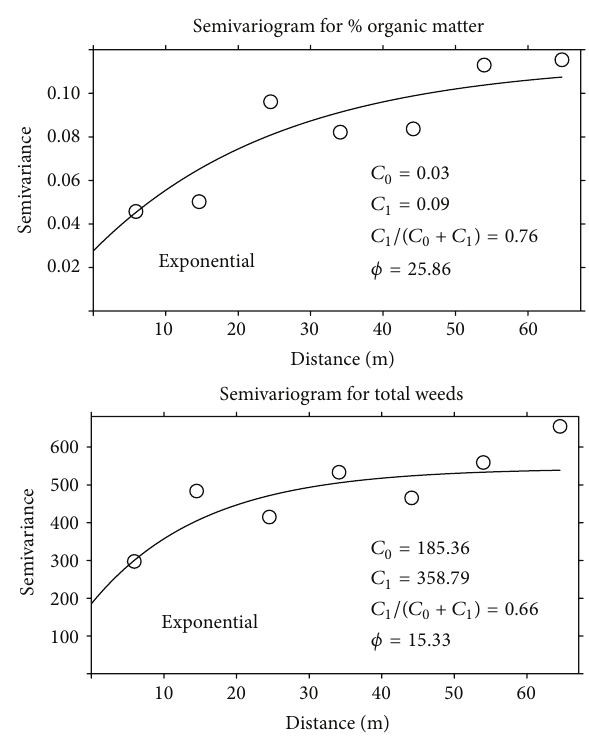
Figure 3: Omnidirectional semivariograms for organic matter and total weeds. 𝐶 0 = nugget, 𝐶 1 = sill, 𝐶 1 /(𝐶 0 + 𝐶 1 ) = proportion of autocorrelation, and 𝜙 =